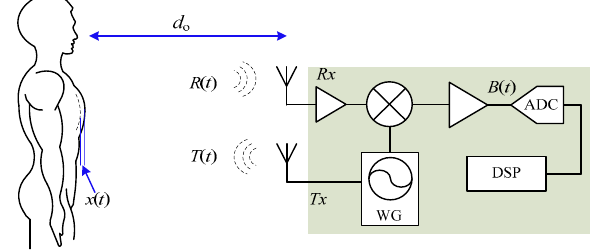
Figure 1. Simplified block diagram of CW/FMCW radar sensor and the mechanism of noncontact vital sign detection. WG: waveform generator.